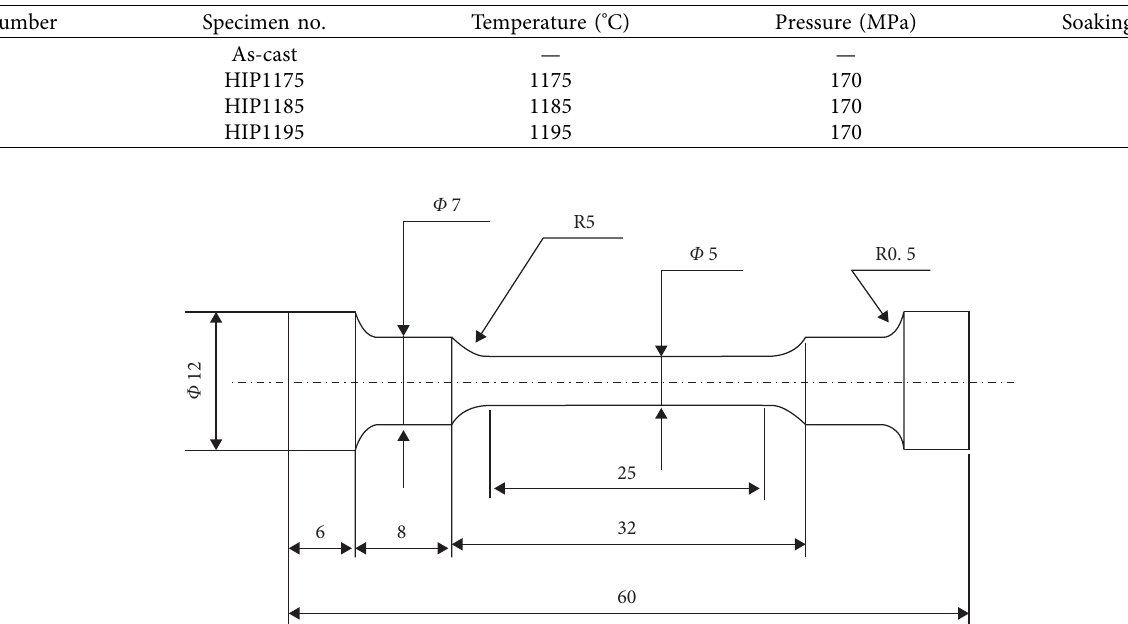
Figure 2: Stress rupture test specimen of the K417G